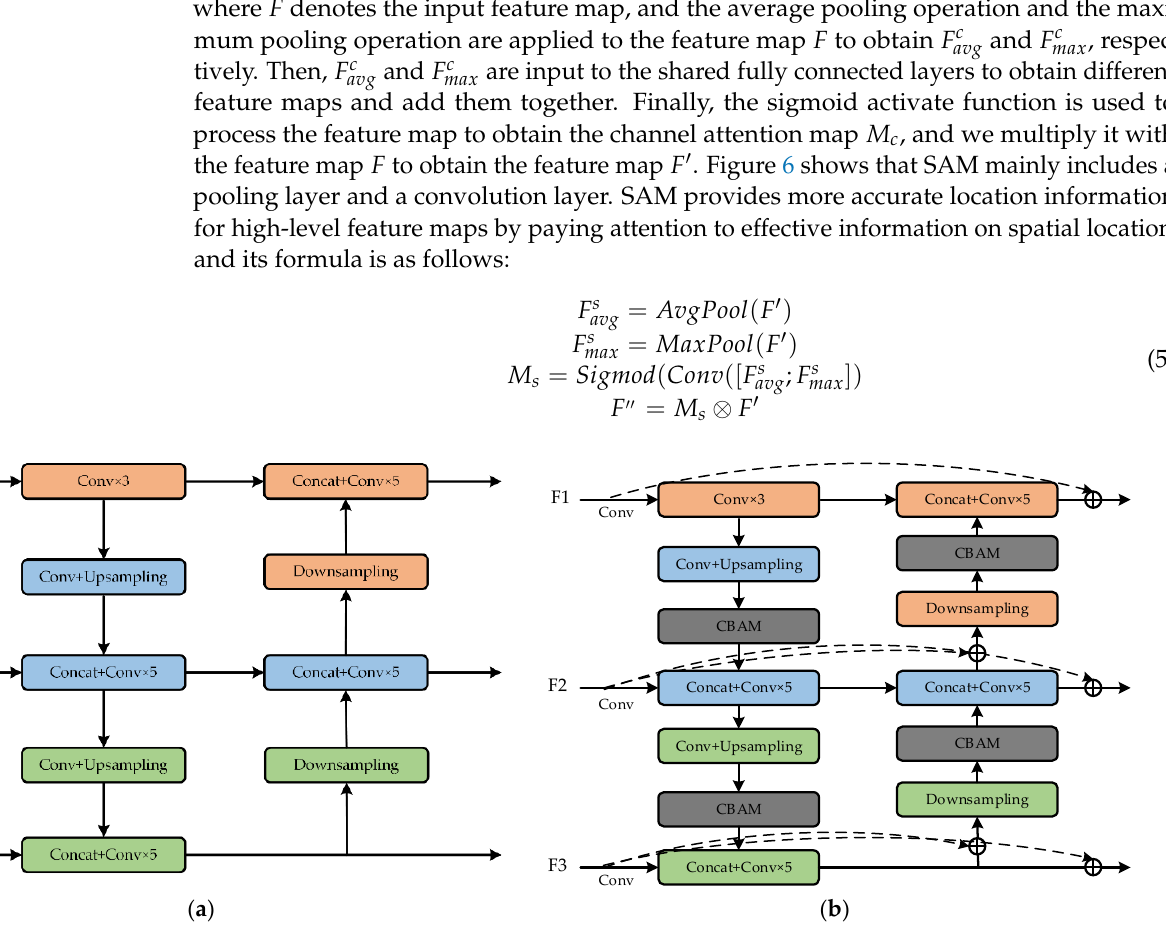
Figure 4. The structure of CBAM.